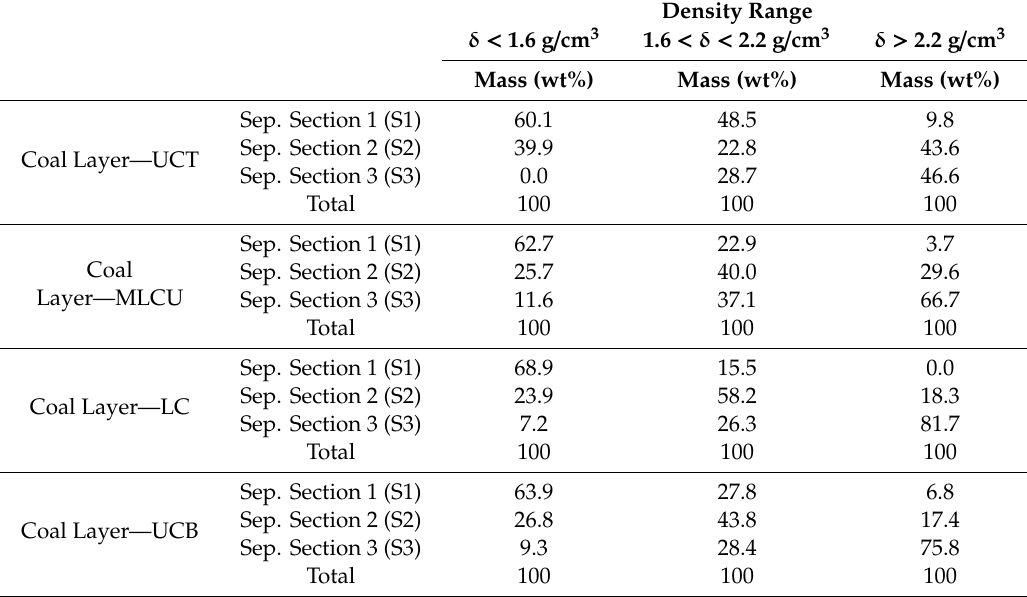
Table 4. Mass recoveries in each density fraction ( δ < 1.6 g / cm 3 , 1.6 < δ < 2.2 g / cm 3 , and δ > 2.2 g / cm 3 ) reported to the three Separation Sections after jigging, for the four coal